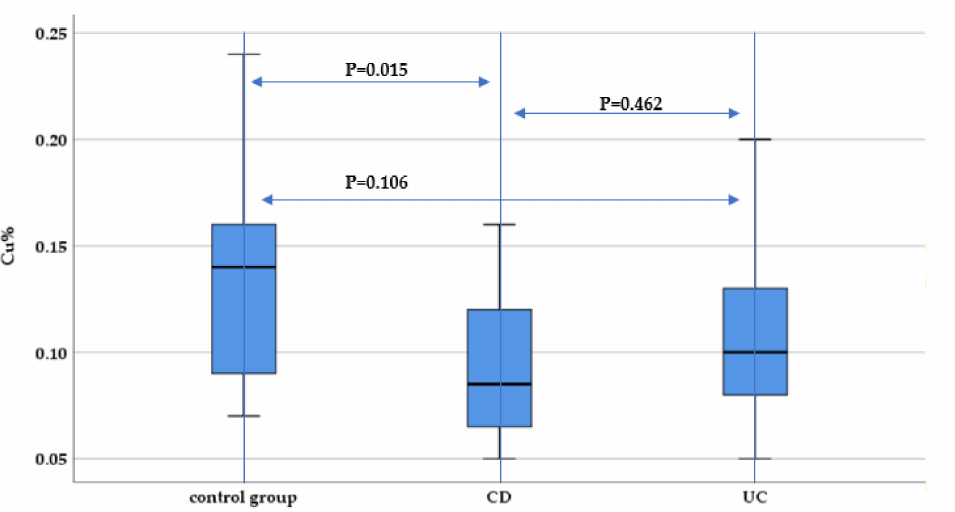
Figure 6. Evaluation of hair copper concentration (Cu%) between IBD subtypes (UC and CD) and the control group. As far as zinc concentration in hair is concerned, there were no statistically significant differences between IBD patients and the control group ( p = 0.697 and p = 0.832), although a slightly lower median hair zinc concentration was identified for UC and CD patients compared to the control group (Figure